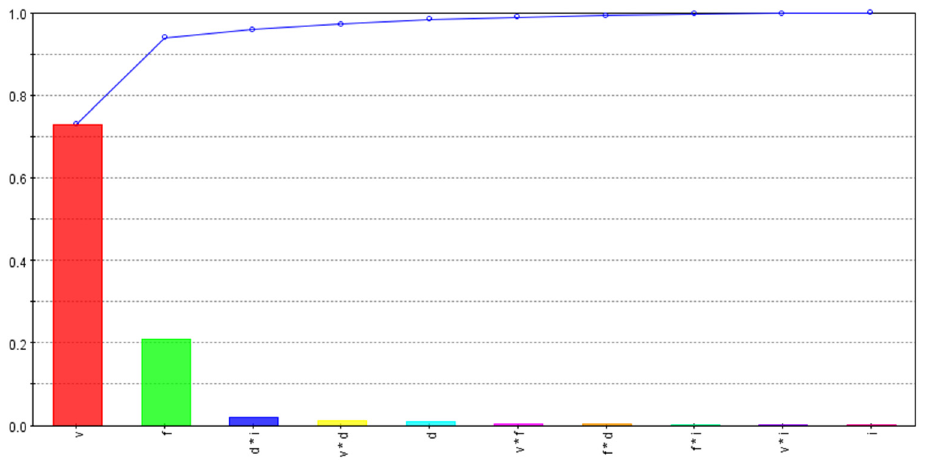
Figure 7. Tool-stress dependencies on input variables and their interactions.